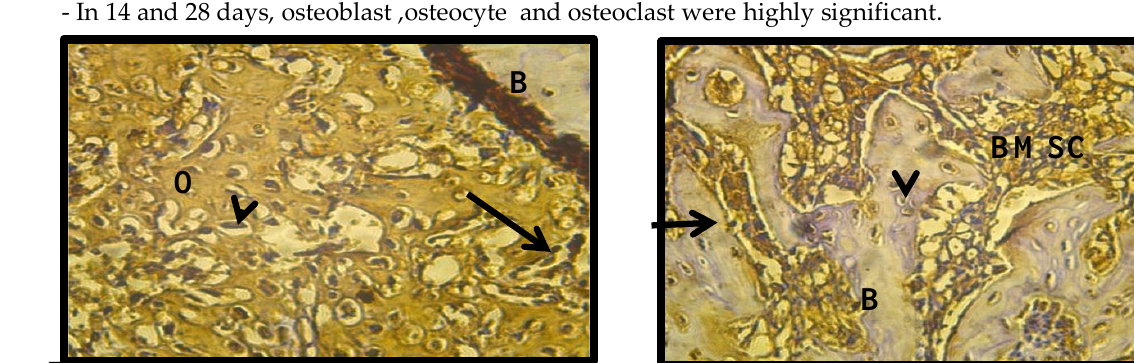
Figure (1) : View of 7 days interval of control group shows positive expression of bone sialoprotein in osteoid tissue (OT), osteoblast ( arrow), osteocyte cells (arrow heads) and shows negative expression in basal bone (BB). DAB stain X40.